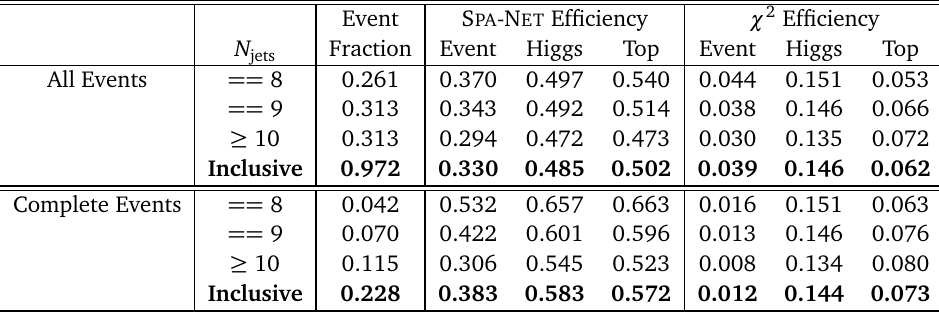
Table 2: Performance comparison for t ¯ tH reconstruction in events with ≥ 4 b -tagged